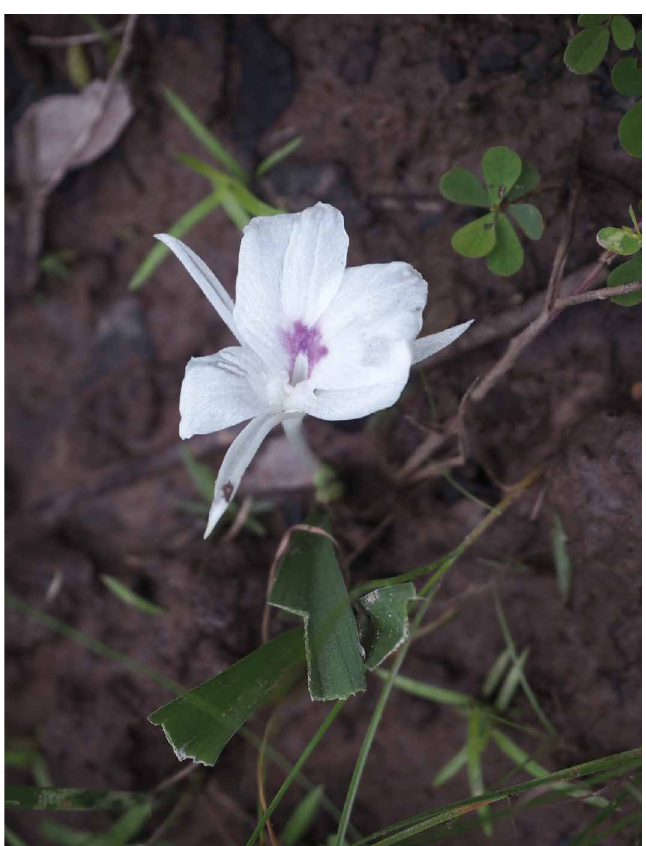
Fig. 4. Kaempferia pascuorum Insis. sp. nov. in natural habitat. Photograph: Oudomphone Insisiengmay.